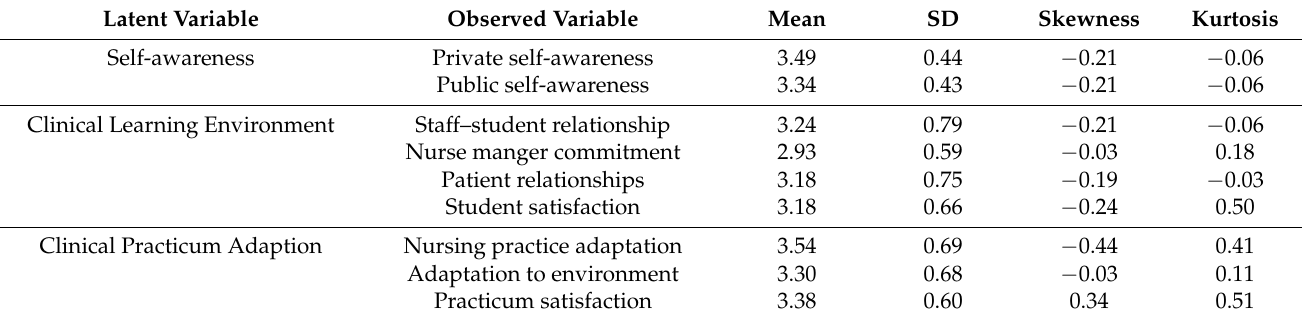
Table 2. Person-centered care competency related variables ( N =